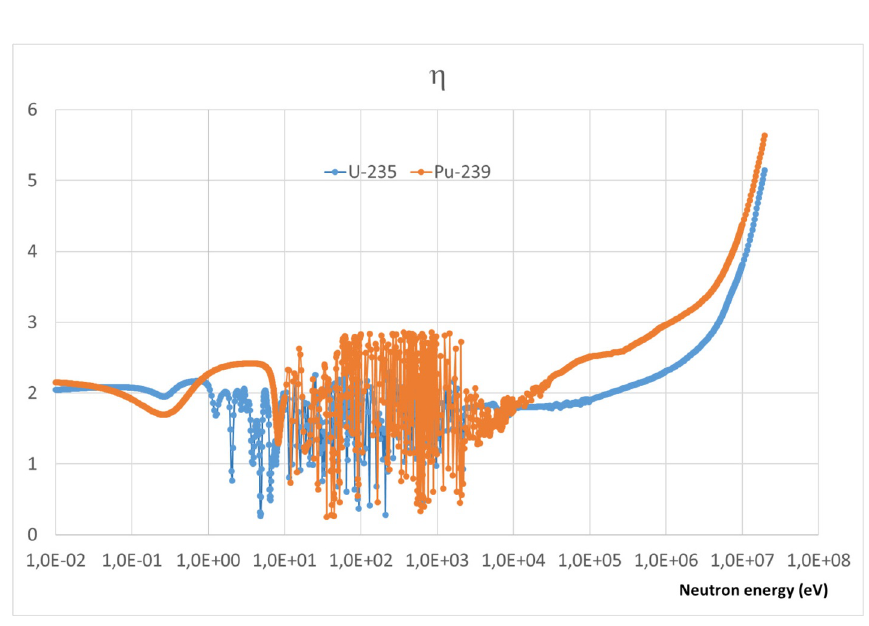
Fig. 4. – The parameter η as a function of neutron kinetic energy for the two main fissile nuclei.